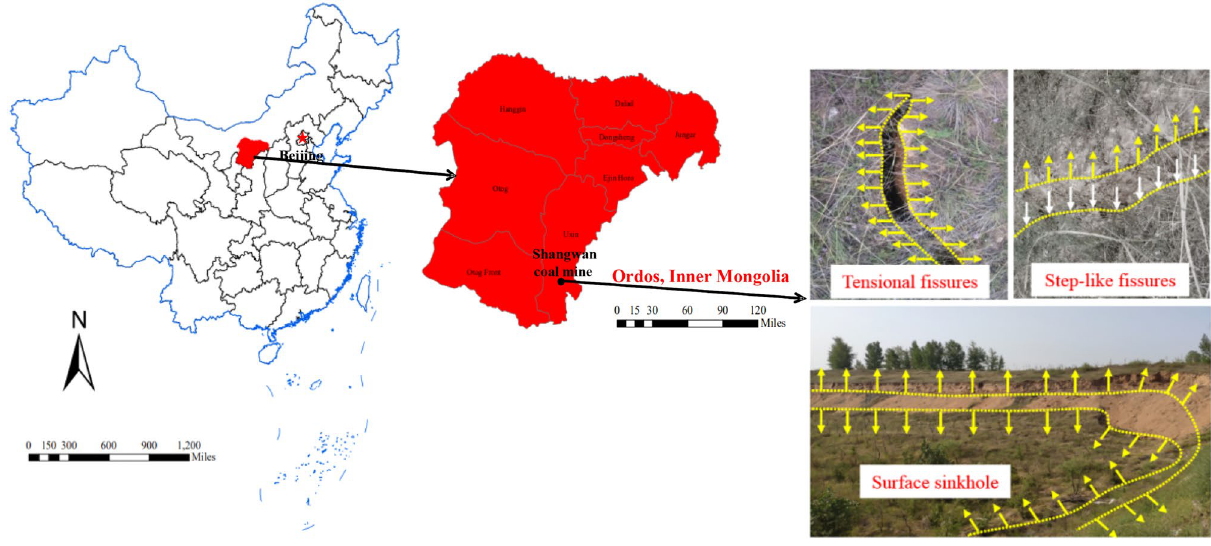
Figure 1. Distribution of ground fissures.